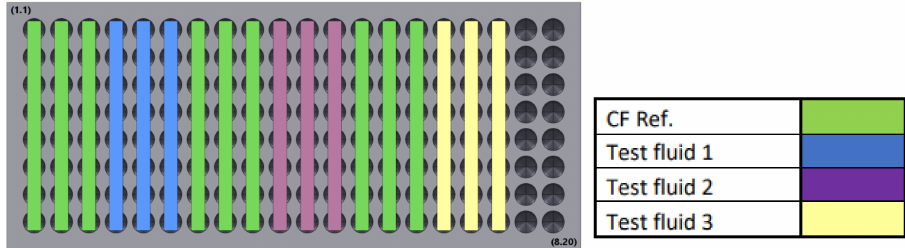
Figure 2. Arrangement of blind holes in each workpiece and allocation of CF groups.